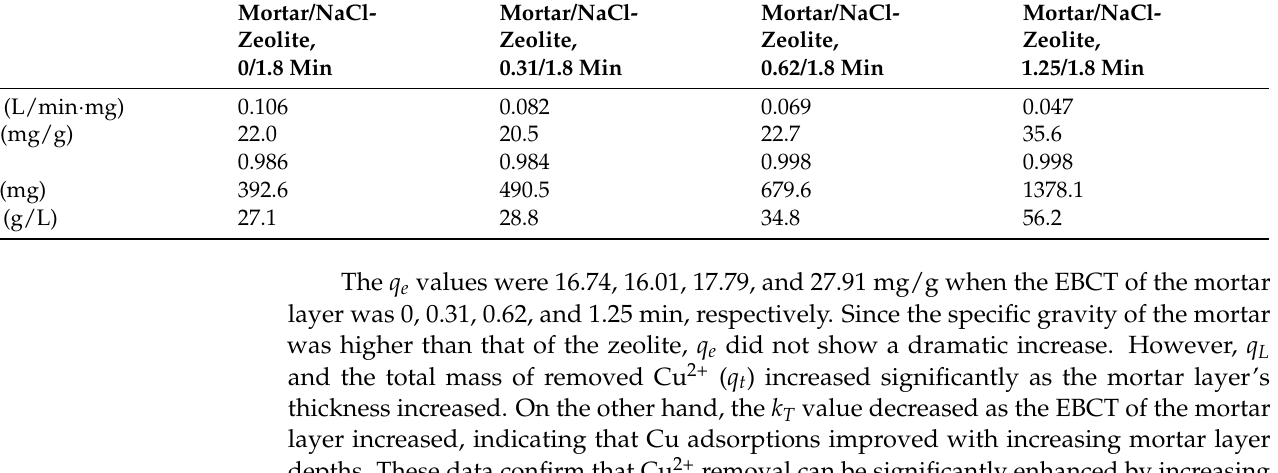
Figure 3. Variations over time in the concentration of Cu 2+ ions in the effluent collected after the dual layer, in mg/L, for different ratios of EBCTs; the working temperature is 20.5 °C.